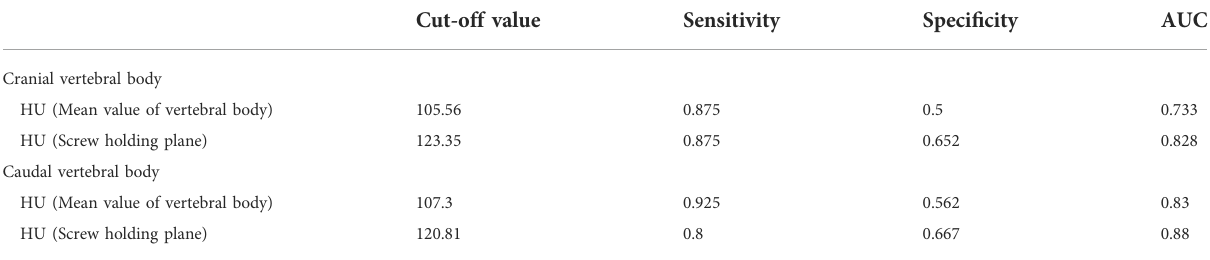
TABLE 6 The cut-off value, sensitivity and speci fi city of four measurement methods for predicting screw